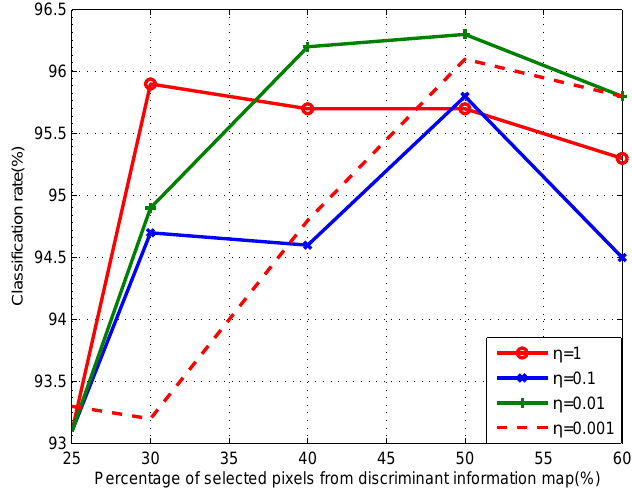
Figure 6. The classification rates with different η